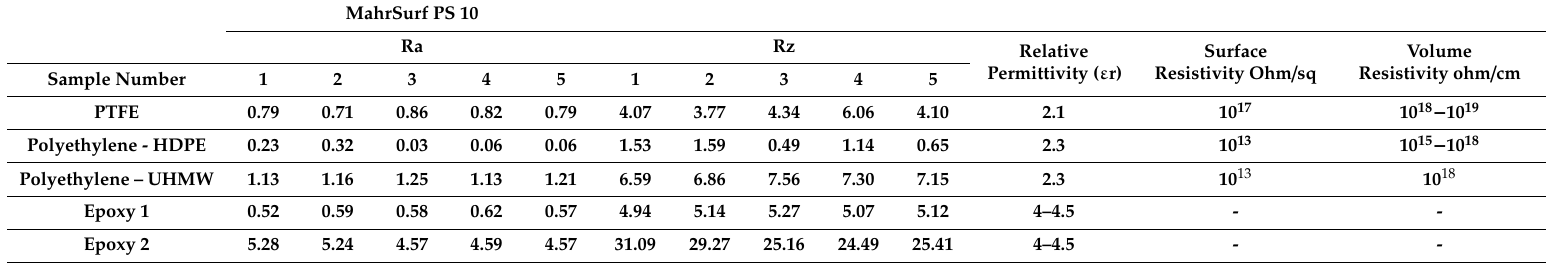
Table 1. Roughness features of tested